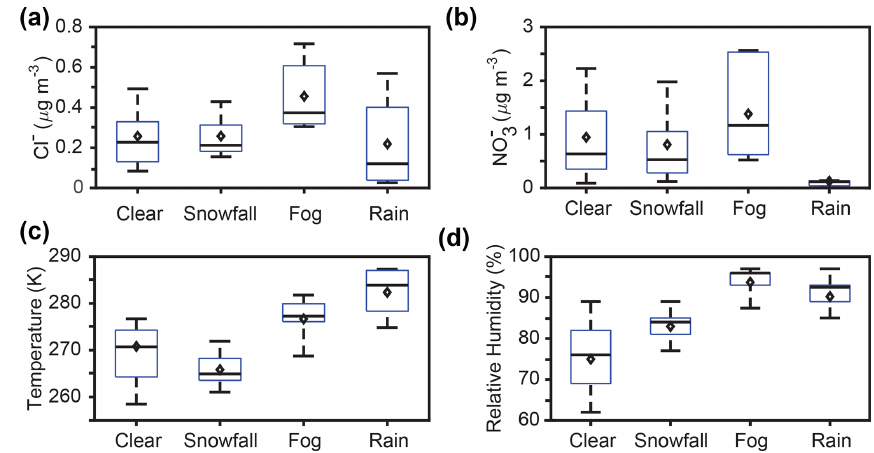
Figure 7. Box plots showing 30min averaged PM 2 . 5 (a) chloride and (b) nitrate concentrations, (c) air temperatures, and (d) relative humidity values during clear conditions and weather events (snowfall, fog, and rain). Bars represent the 10th, 50th, and 90th percentiles, boxes represent the 25th and 75th percentiles, and diamonds represent the means. Only nighttime data, between 18:00 and 08:00EST, are